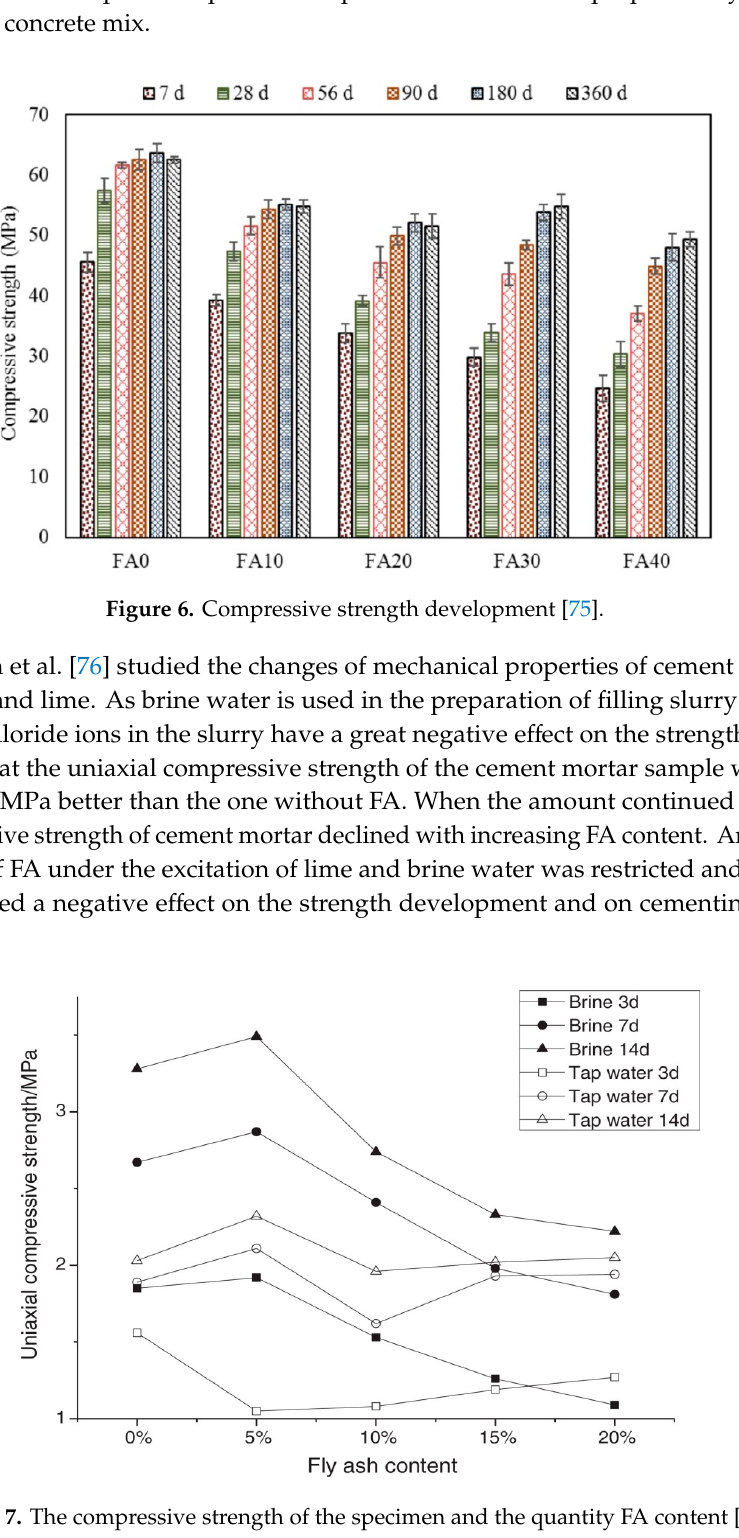
Figure 7. The compressive strength of the specimen and the quantity FA content